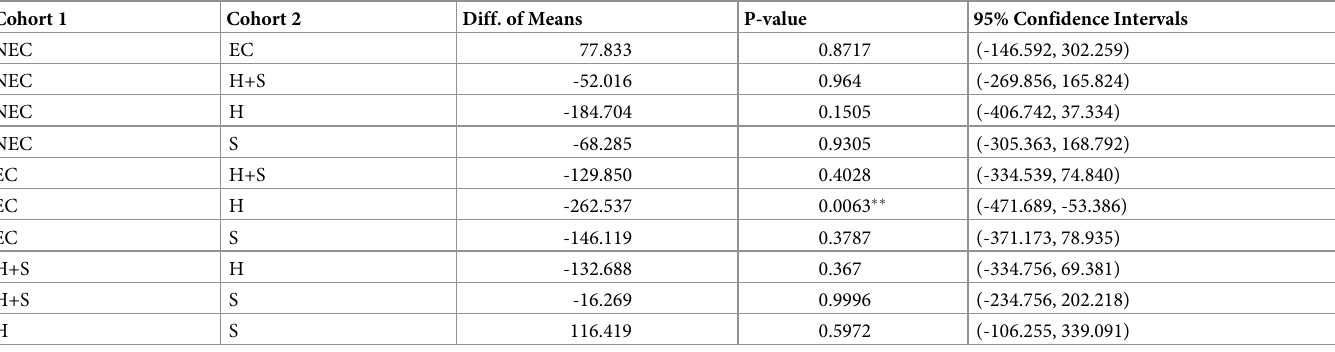
Table 1. Pairwise Tukey’s Post-hoc of TFF2 levels, sexes pooled.